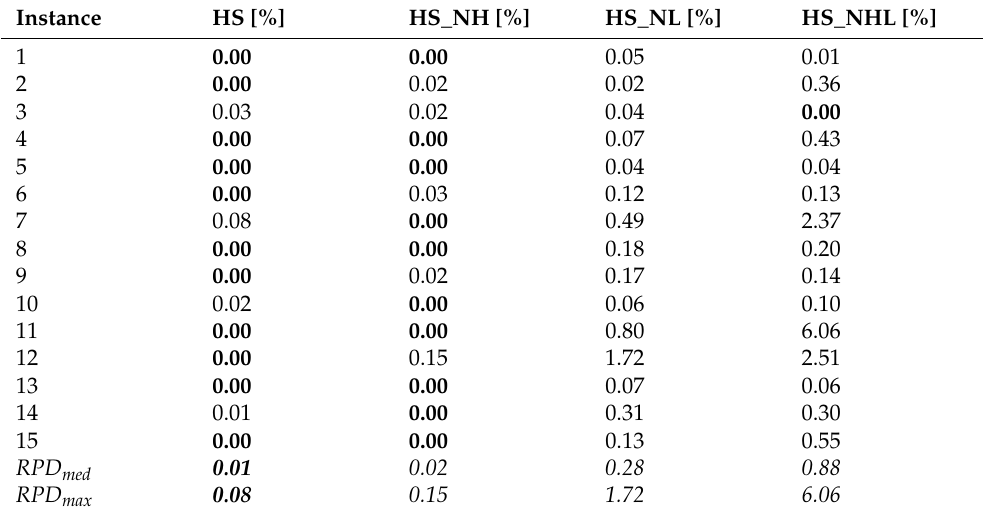
Table 6. Design of HS: RPD values.